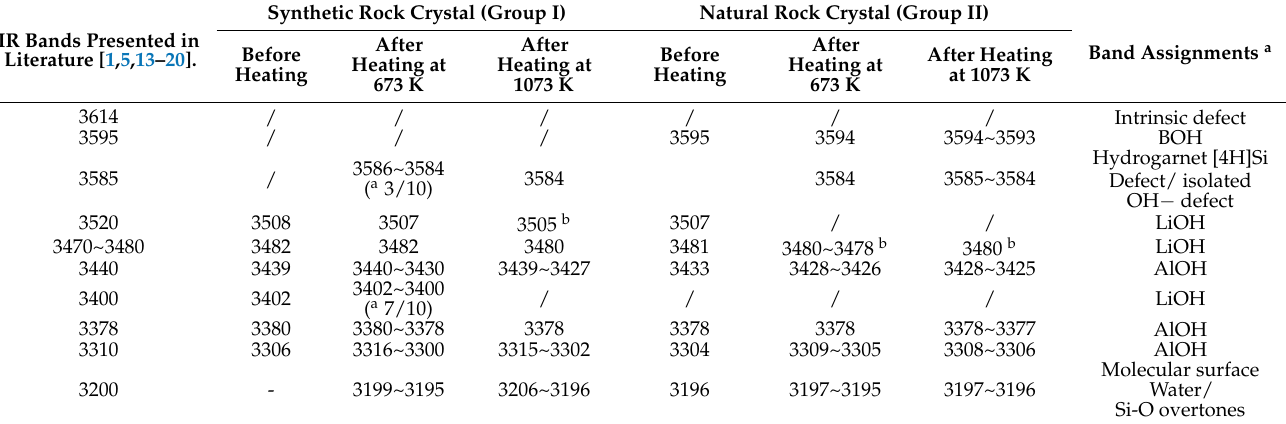
Table 1. IR peak locations (cm − 1 ) and assignments for absorption bands of natural and synthetic rock crystal before and after heat treatment. IR Bands Presented in Literature